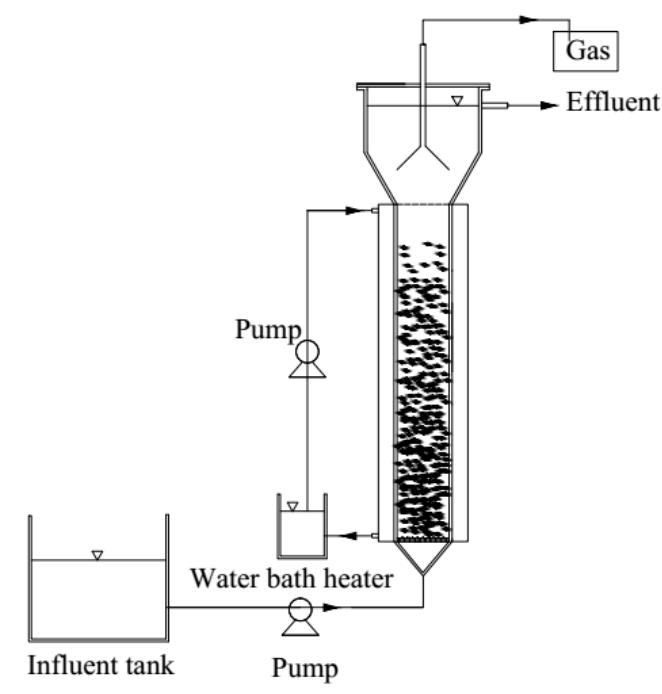
Figure 1. Schematic diagram of the Anammox-up-flow anaerobic sludge blanket (UASB) reactor.